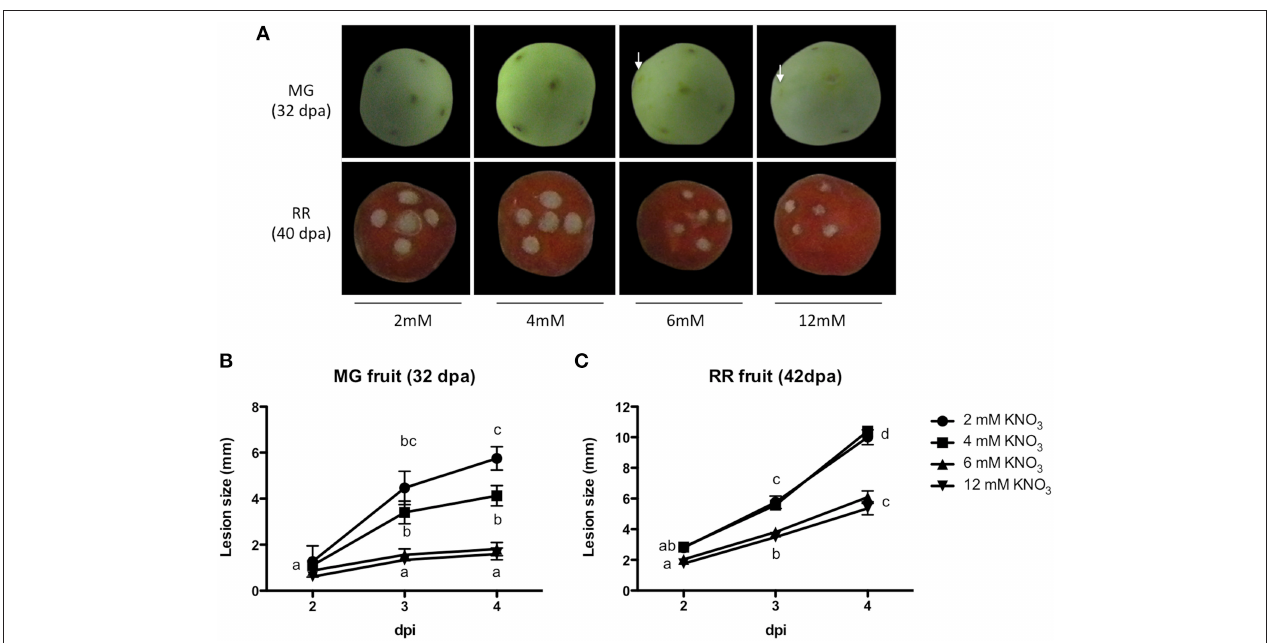
FIGURE 2 | Tomato fruits susceptibility to B. cinerea obtained from plants grown under different nitrate concentrations. (A) Representative inoculated fruits (3 dpi) for each nitrate concentration and ripening stage (dpa, days post-anthesis). (B,C) Lesion size (diameter) for inoculated MG and RR fruits, respectively. For MG fruits, white arrows indicate the site of infection with minimal necrotic lesion. Different letters indicate significant differences among treatments at a given time point ( p ≤ 0.05 ; error bars indicate SEM; n = 4